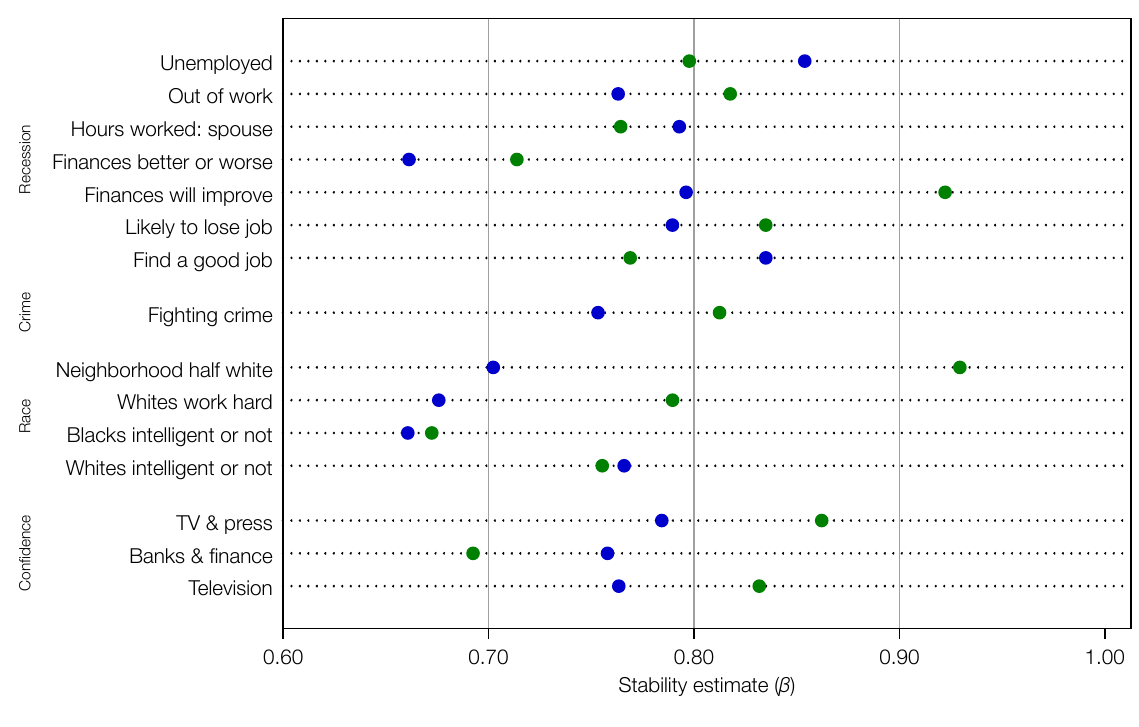
Figure 10: Stability estimates for items with relatively low